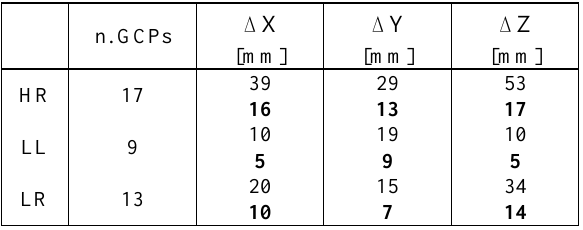
Table 4. UAV photogrammetric block - GCPs residual errors along Vallone d'Elva road.